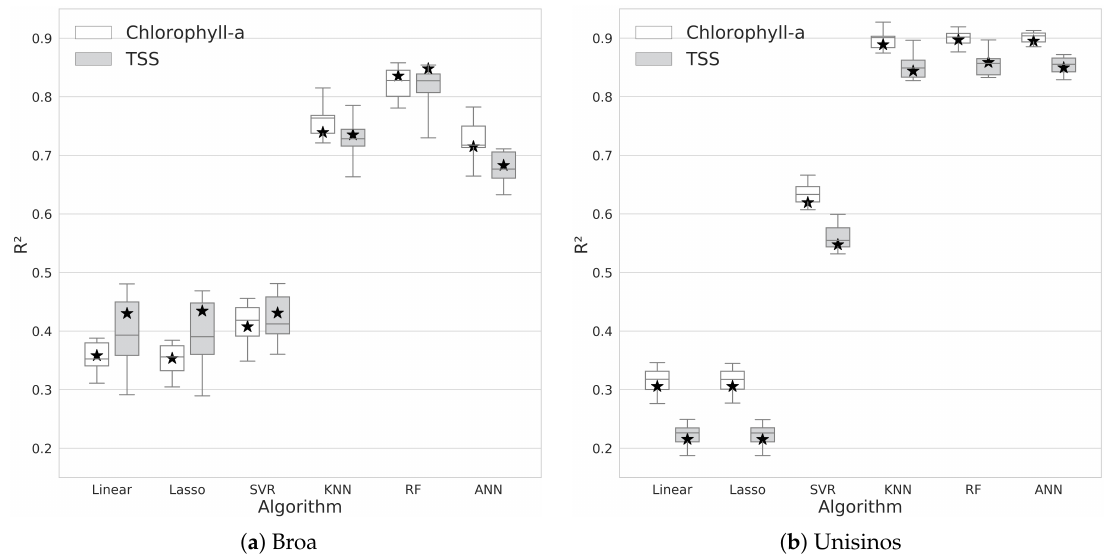
Figure 5. Boxplot representing the R 2 metric obtained on the cross-validation; the metric on the test set is marked with a